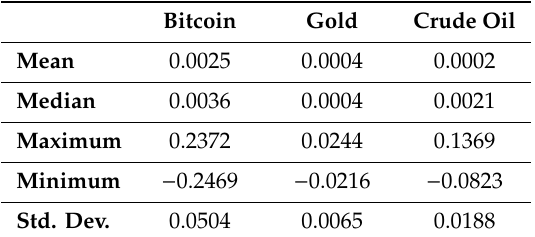
Table 1. Descriptive statistics for the daily return